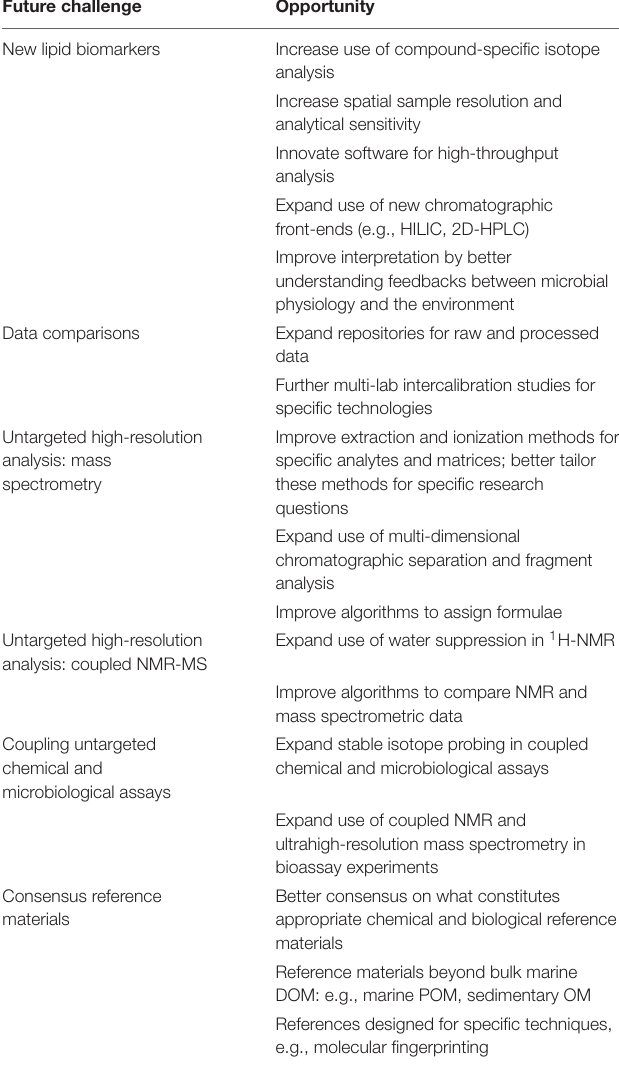
TABLE 1 | Summary of future challenges and